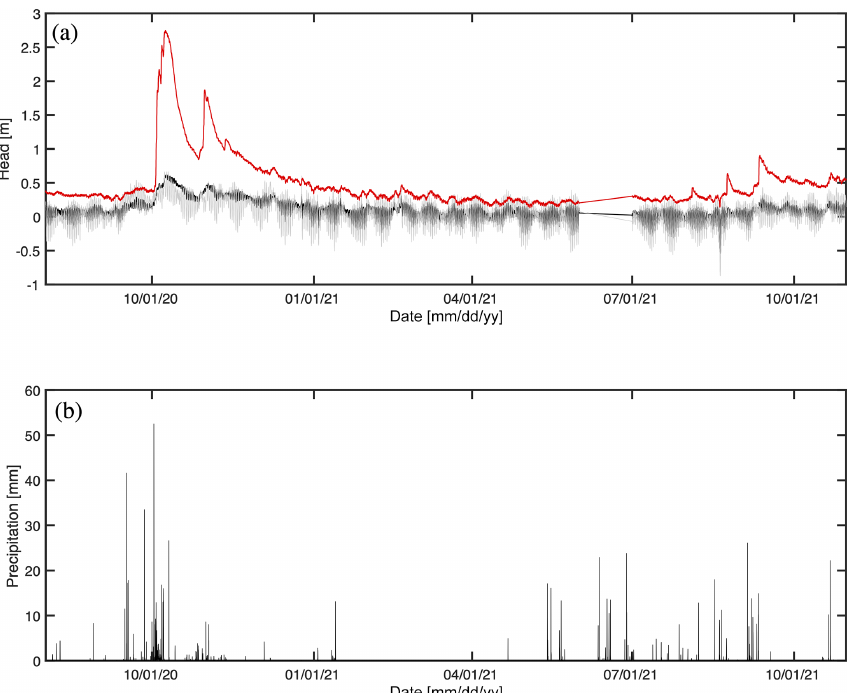
Figure 10. Times series of (a) the hydraulic head at three coastal monitoring wells (W4: solid black line; W5: solid gray line; W7a: red line), and (b) precipitation, recorded at the coastal weather station, in Sisal, Mexico. There are missing data due to sensor failure (a) during June 2021 and (b) from January to April and from September to October 2021.